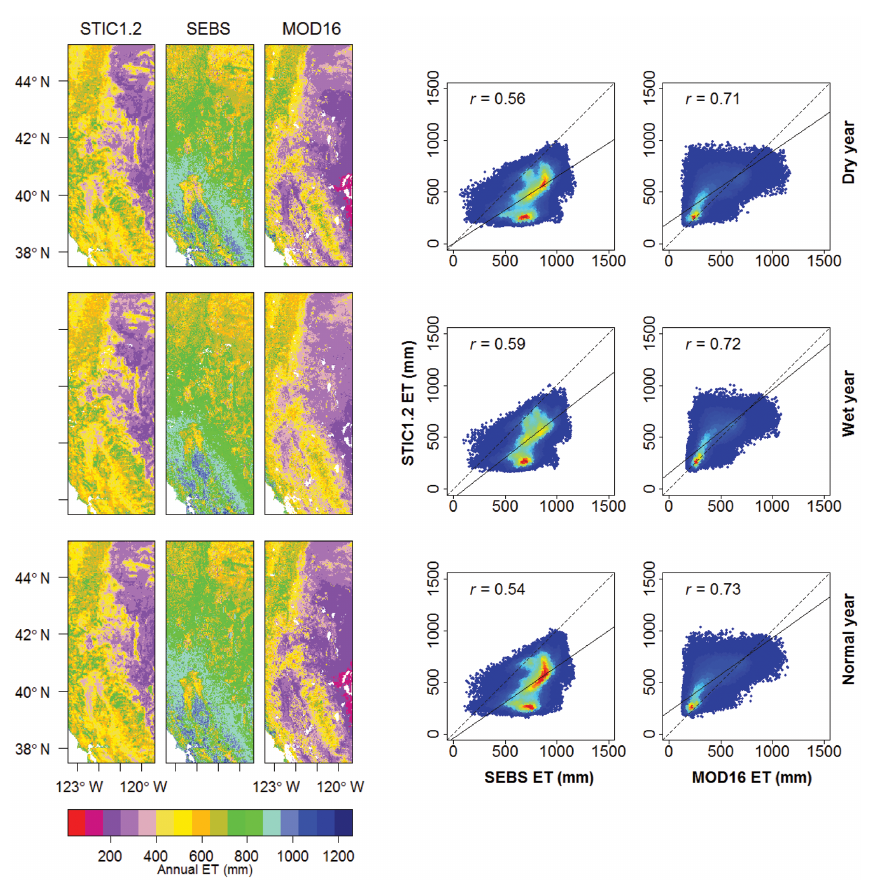
Figure 8. Annual ET (mm) maps for the dry, wet, and normal years derived from STIC1.2, SEBS, and MOD16 for the western (W) bounding box covering US-Ton and US-Me2 flux sites (Fig. 1). Scatter plots between annual ET estimates from STIC1.2 vs. SEBS and MOD16 are shown on the right.